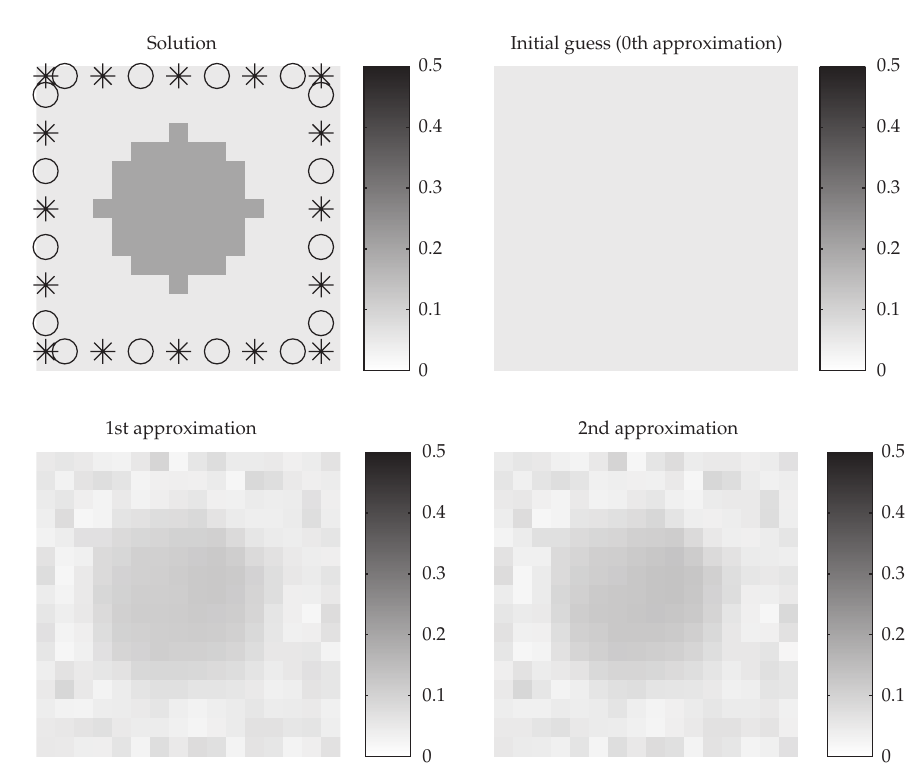
Figure 1: Jindex (cid:10) Nx ∗ Ny ∗ 0 . 4, Jalpha (cid:10) 6 . 4920 e − 009, 10% noise, sources (cid:6) ∗ (cid:8) , and detectors (cid:6) o (cid:8)